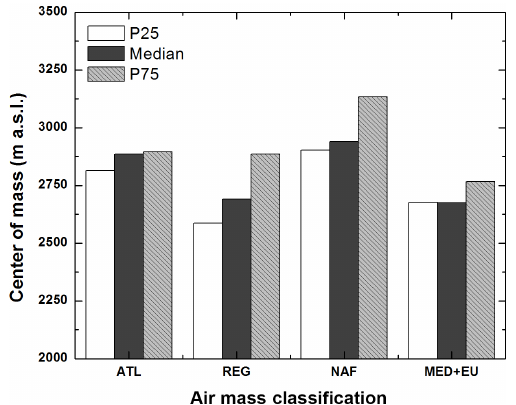
Figure 7. Bar plot of the center of mass in meters above sea level (ma.s.l.; note that the MSA observatory is at 1570ma.s.l.) of the 25th percentile (P25), median and 75th percentile (P75) profiles, separated as a function of air mass (ATL: Atlantic, REG: Regional, MED+EU: Mediterranean and European, NAF: North